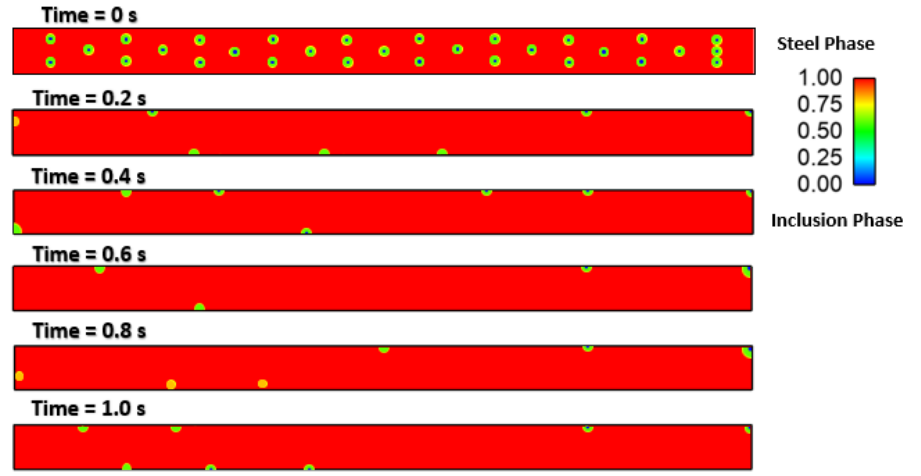
Figure 6. Motion of alumina inclusion during solidification (initial temp: 1893 K, sulfur: 10 PPM).